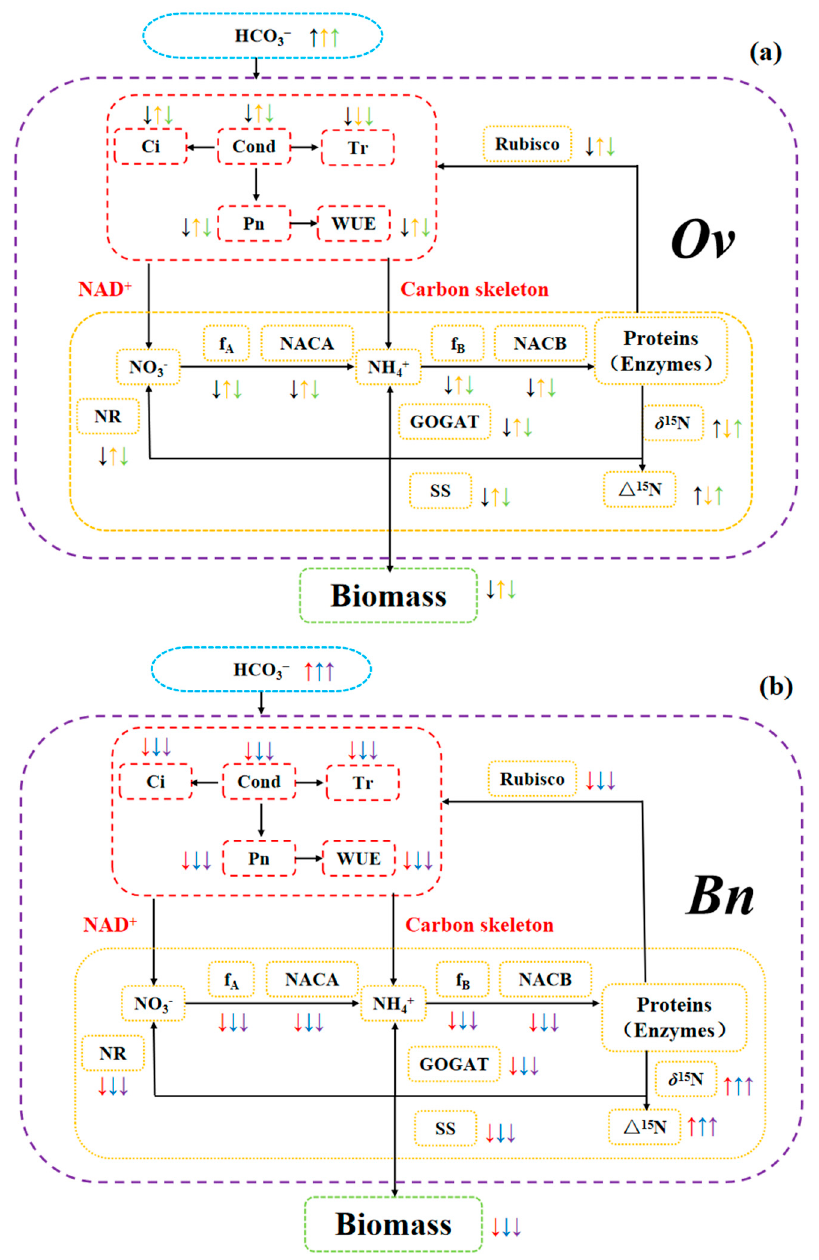
Figure 6. Differential responses of carbon and nitrogen metabolism to bicarbonate in Ov and Bn under simulated karst habitats. ↑ : Increase, ↓ : Decrease. ( a , b ) represented differential responses of carbon and nitrogen metabolism to bicarbonate in Ov / Bn under simulated karst habitats. The balck, yellow and green/ the red, blue, and purple arrows represent different bicarbonate treatments at 1 mM, 5 mM, and 15 mM in Ov / Bn .